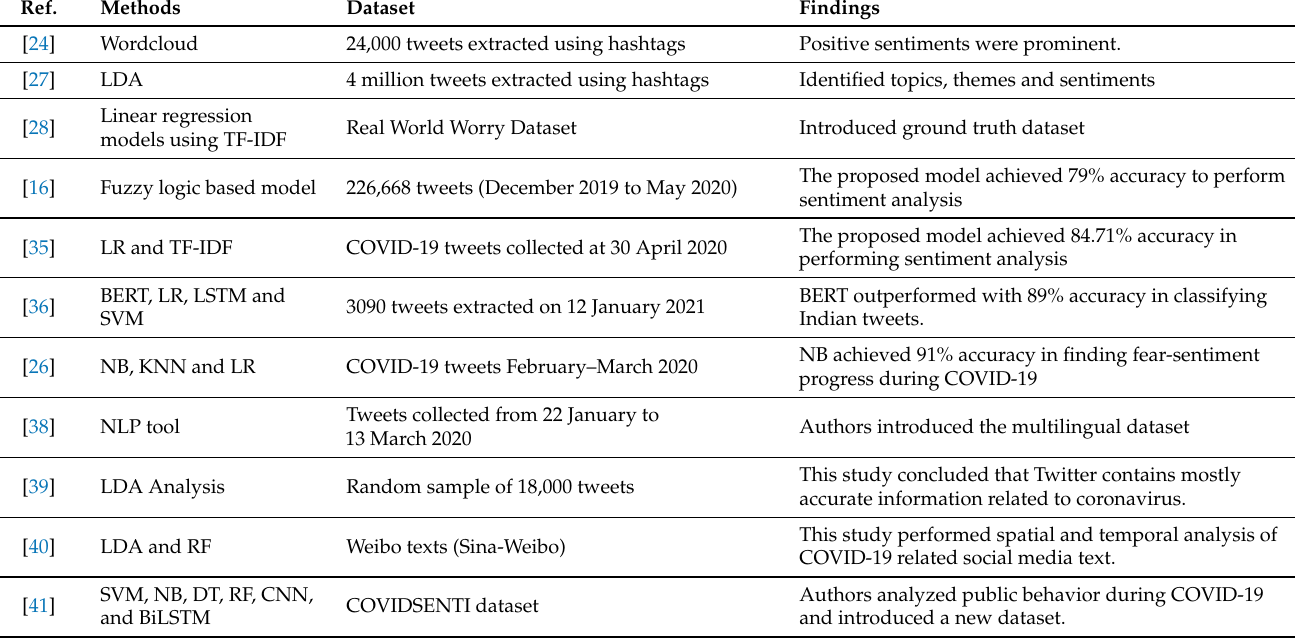
Table 1. Comparative analysis of the existing